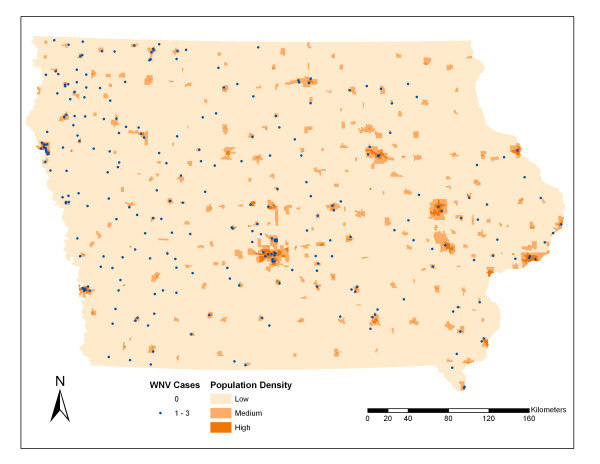
Centroids of census block groups with WNV disease overlain on Iowa population density. The centroids of those census block groups with WNV disease are overlain on a layer of populations density spit into three classes (Low = 0 – 0.5 persons/ha, Medium = 0.5 – 4 persons/ha, and High > 4 person/ha).